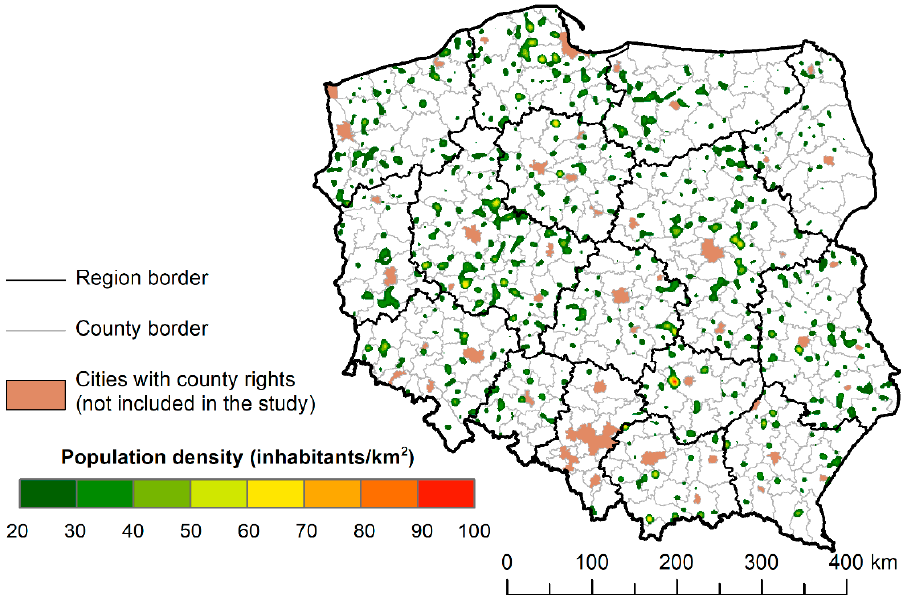
Figure 6. Population density in rural areas situated beyond 6 km from PHC facilities. Table 5. Estimated percentage of the area of voivodeship with weaker access to PHC facilities in rural areas with population density above 20 people/km 2.